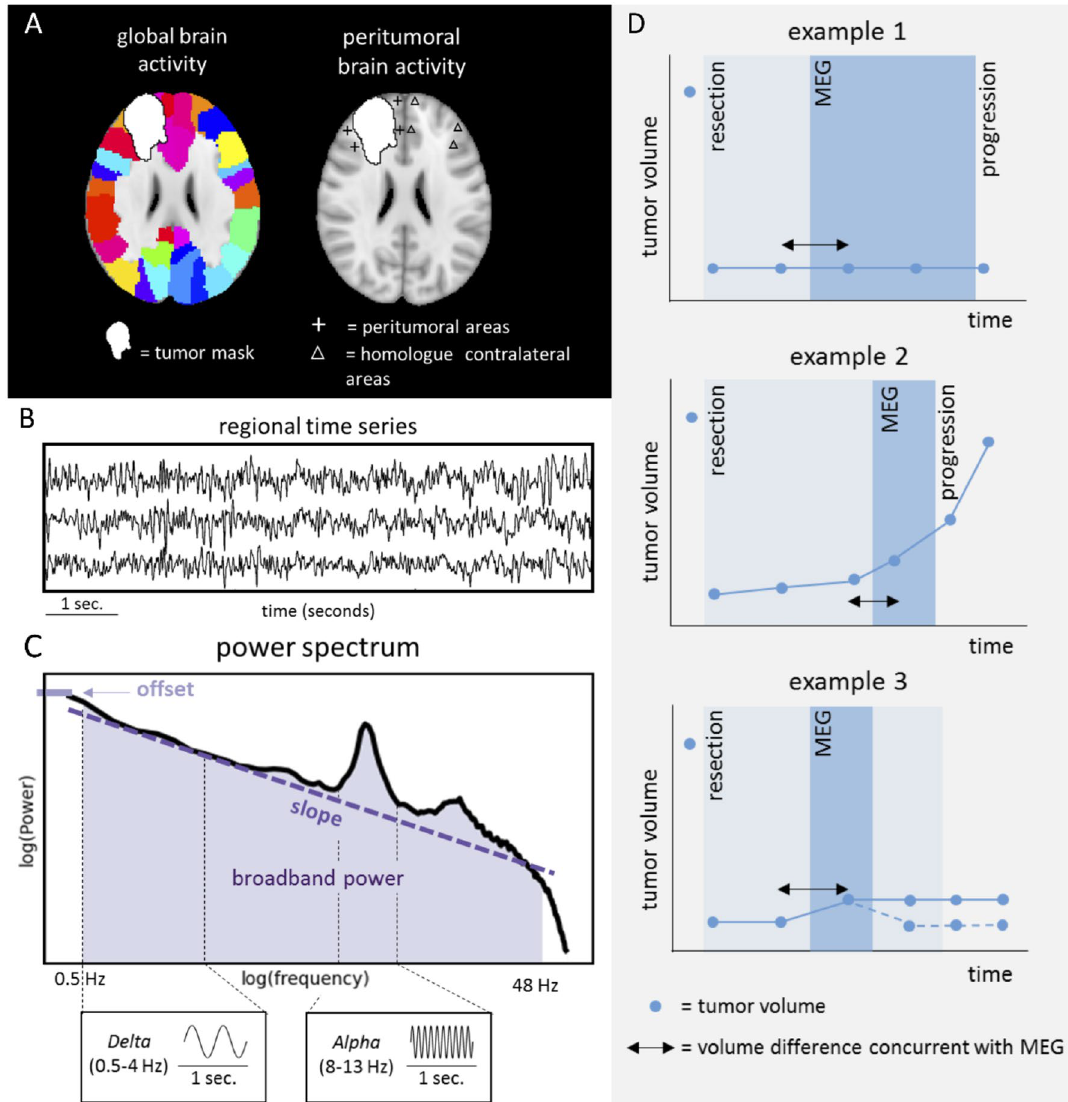
Figure 1. Schematic analysis pipeline of brain activity and tumor volumes. A Time-series were extracted across regions (left panel) and then averaged to obtain estimates of global brain activity. Peritumoral brain activity was obtained using peritumoral areas (cross hairs) at maximum 3 cm of the tumor or resection cavity and thereafter normalized according to activity of homologue contralateral regions (triangles). B Three exemplar regional time-series. C The power spectrum shows which frequencies, and with which strength, are present in the time-series, with slower frequencies on the left (e.g. delta 0.5–4 Hz) and faster frequencies on the right (e.g. alpha 8–13 Hz). Broadband power was defined as the area under the power spectrum between 0.5 and 48 Hz (shaded area). The offset is the power at the lowest included frequency (0.5 Hz). The slope of the power spectrum is indicated by the dashed line. In D , three hypothetical trajectories of patients’ radiological volumes, magnetoencephalography (MEG) measurements and progression as determined by the tumor board are shown. Tumor volume was obtained from all available scans (indicated by blue dots). Example 1 represents a hypothetical patient with stable tumor volume. Example 2 represents a hypothetically radiologically progressive patient (i.e. increasing volume). Example 3 represent a hypothetical patient classified as having radiologically stable tumor volume, because the initial small increase in tumor volume became stable at the next time points (continuous line) or returned to a lower volume indicating potential pseudoprogression (dashed line). The time between MEG and progression as defined by the tumor board is marked with shaded blue and may deviate from radiological tumor growth as operationalized in our